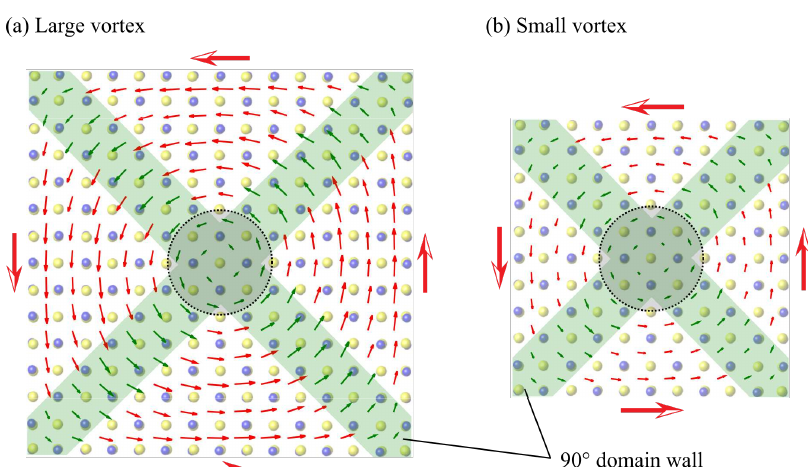
Figure 12. Schematic illustration of domain structure in the SnTe nanoflake consisting of 90° domain walls. Red arrows indicate spontaneous polarization and green areas indicate domain walls.